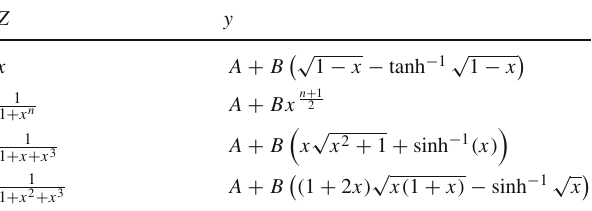
Fig. 20 Variation of forces in TOV-equation versus the radial variable x